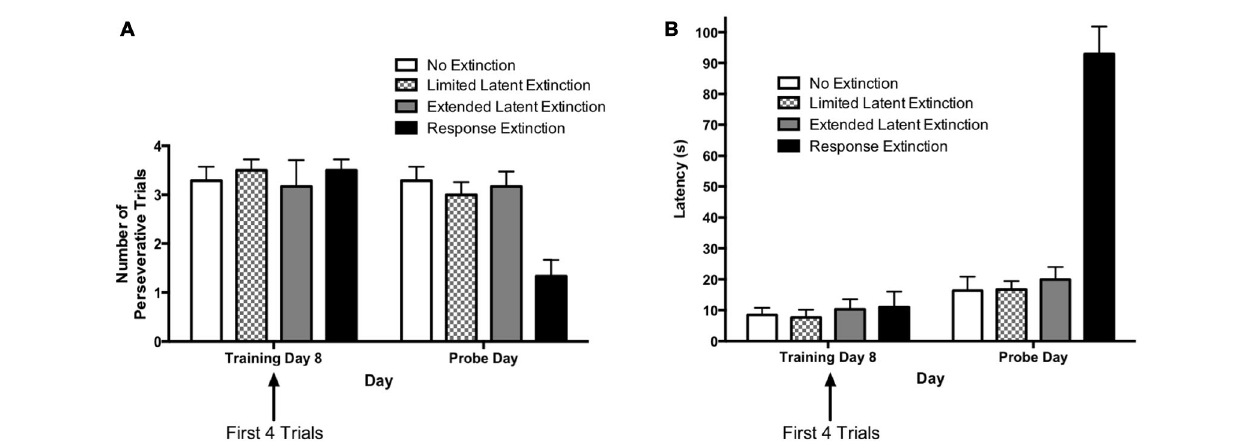
FIGURE 6 | Extinction probe trials in the DLS-dependent response learning task. (A) There were no differences between groups in perseveration during the first few trials of the last acquisition day (i.e., training day 8). Only the response extinction group displayed a decrease in number of perseverative trials from the last acquisition day to the probe day. On the probe day, the response extinction group displayed lower perseveration than all other groups. The latent extinction groups (limited and extended) did not differ in perseveration from the no extinction control group on the probe day. (B) There were no between-group differences in latency on the last training day. All groups increased latency from the last acquisition day to the probe day. On the probe day, the response extinction group had higher latency than all other groups. Latency was not higher in the latent extinction groups (limited and extended), relative to the no extinction group. Results indicate that response extinction was effective and latent extinction was ineffective at extinguishing memory of DLS-dependent response learning.